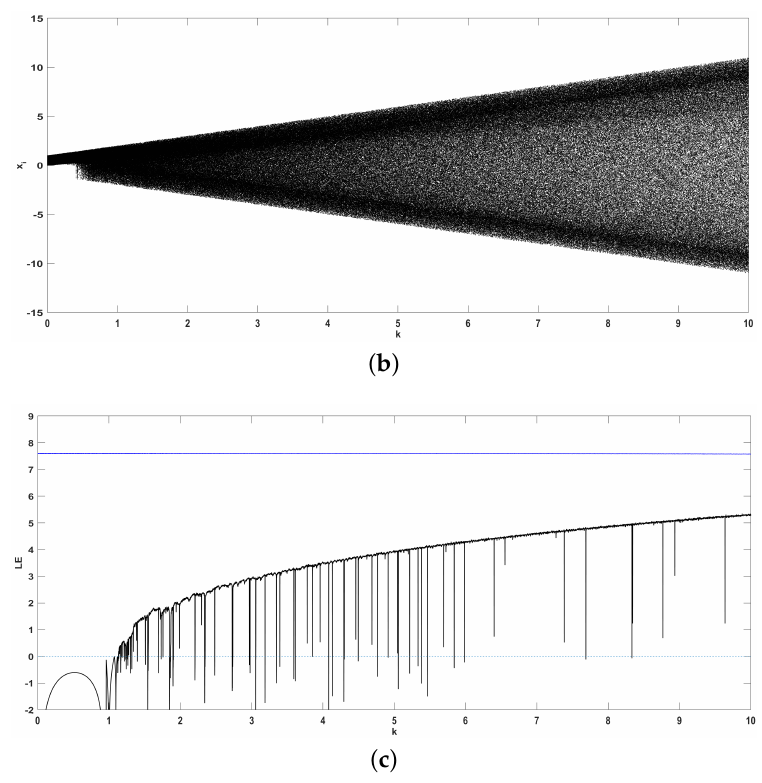
Figure 13. Bifurcation diagrams for ( a ) the cosine-logistic map (28) and ( b ) modified cosine-logistic map (29) with respect to parameter k , for r = 4, a = 2000, N = 1. ( c ) LE of the cosine-logistic map (28) (black) and modified cosine-logistic map (29) (blue).